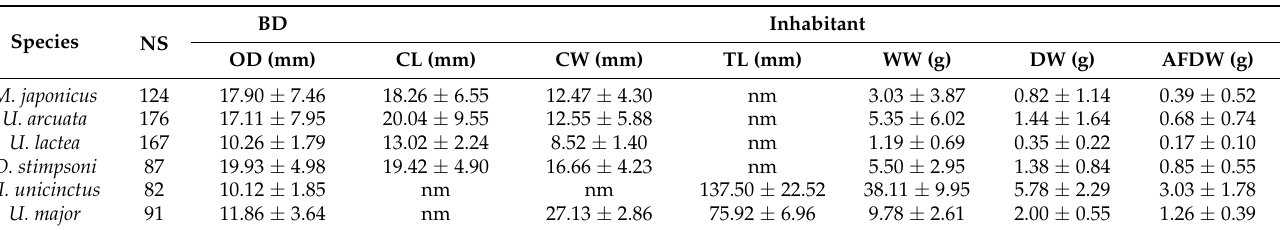
Table 2. Comparison of burrow opening diameters and morphometric data for each species (mean value ± standard deviation).